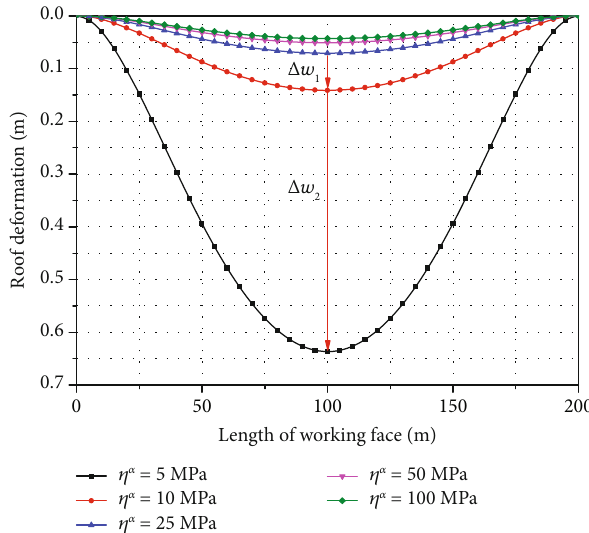
Figure 10: Roof subsidence with di ff erent time.